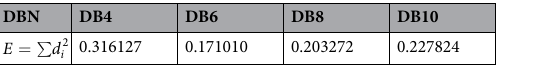
Table 1. Total energy of the high frequency system after wavelet DBN decomposition.